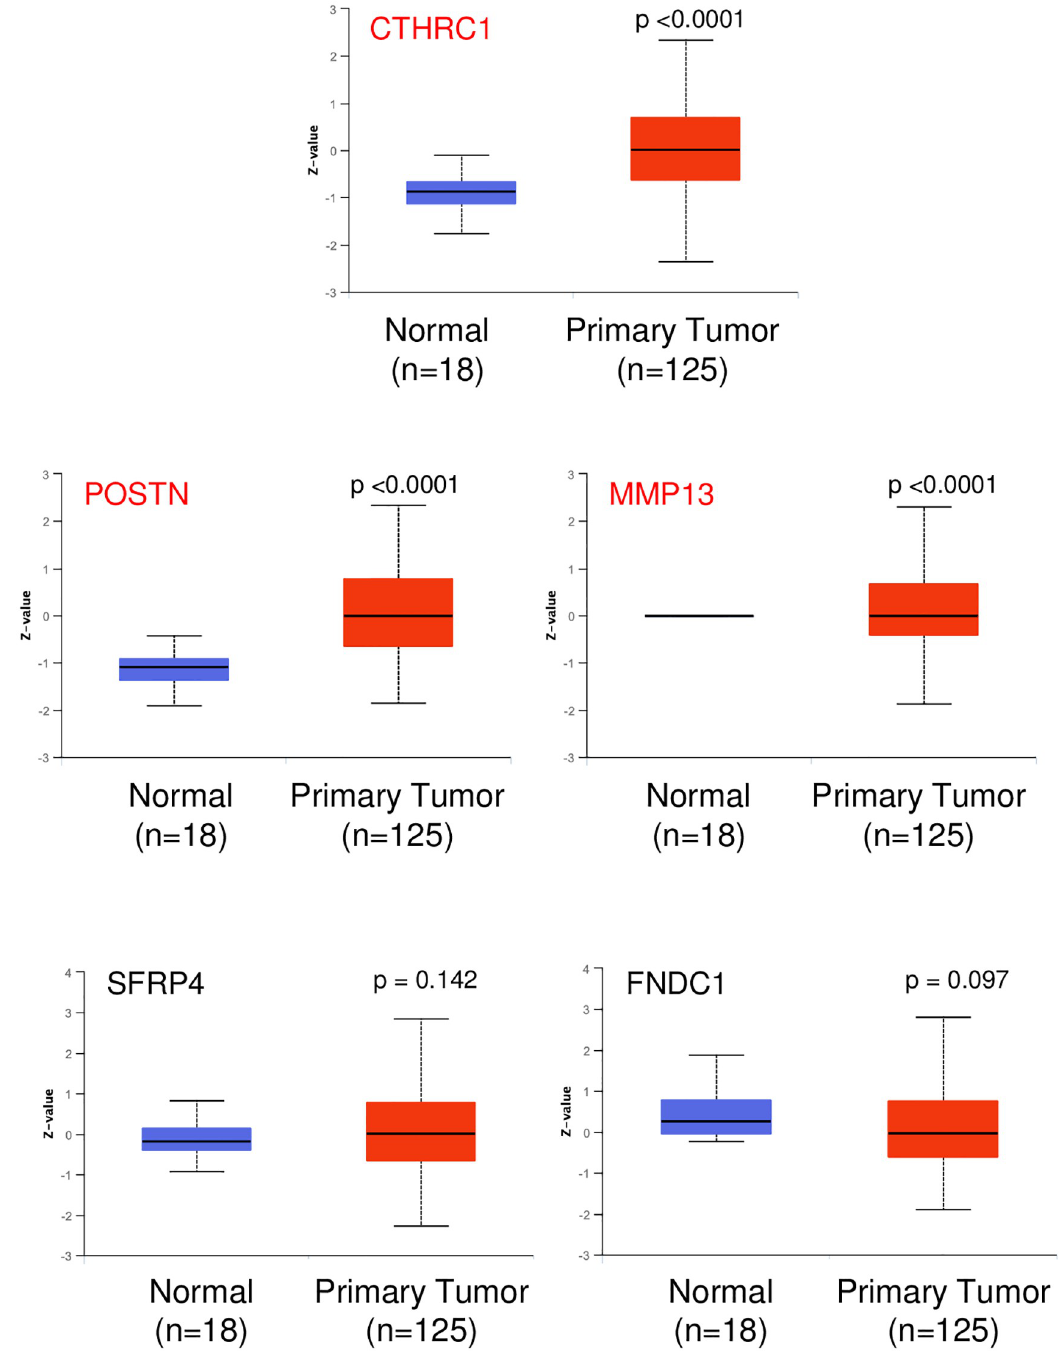
Fig 6. Protein levels of CTHRC1 and network genes in breast cancer. Graphs represent protein levels of CTHRC1 and shortlisted network genes (POSTN, MMP13, SFRP4 and FNDC1) in normal (BLUE) versus tumour tissue (RED) data from the UALCAN Portal. The box plot shows the median ± standard deviation. p values are as indicated and calculated using the students t-test. Genes with significance (p < 0.05) are listed in RED and those lacking significance in BLACK.